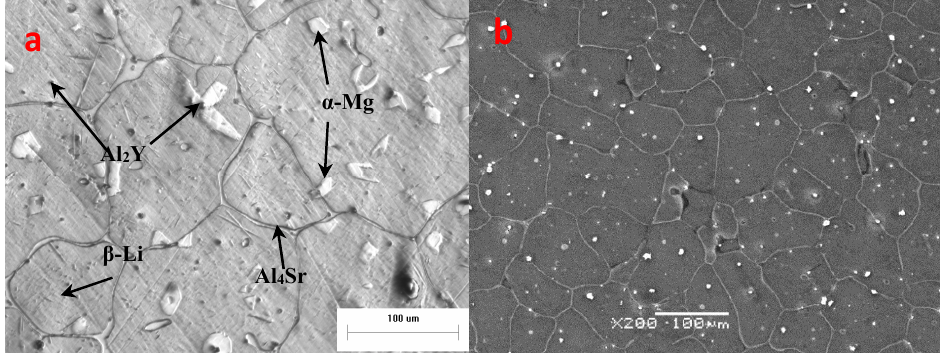
Figure 2. The photographs of as-homogenized alloy: ( a ) The optical microscope (OM) photograph; ( b ) The SEM photograph.